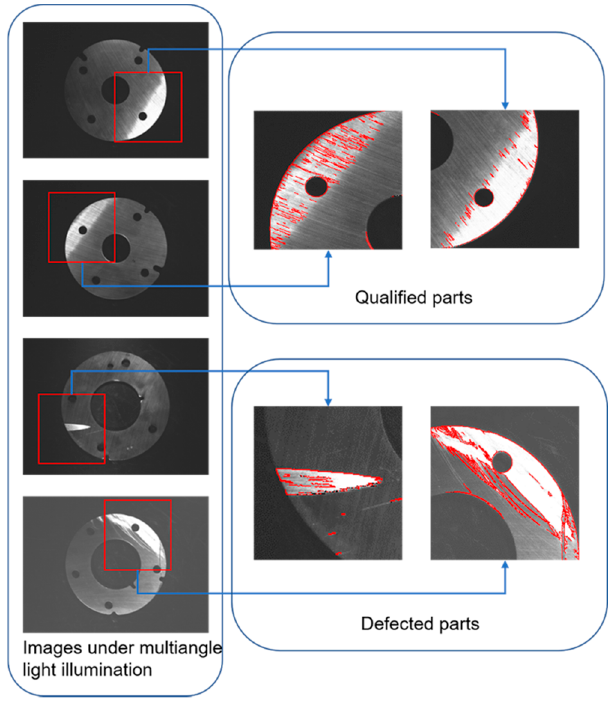
Figure 13. Edge extraction of gray anomaly region.